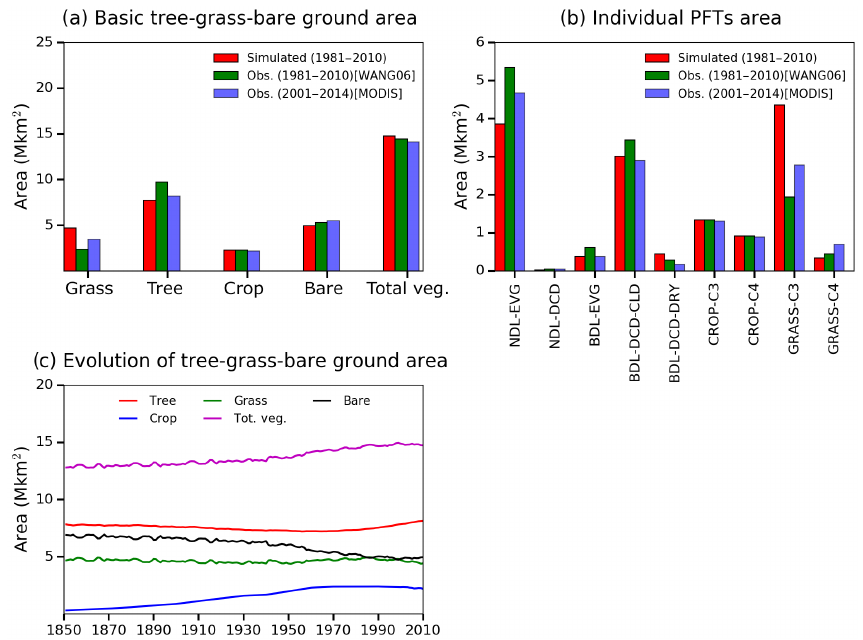
Figure 2. Comparison of observation-based and simulated vegetation areas summed over the North American domain: (a) grass, tree, crop, bare ground and total vegetated area; (b) individual PFT areas; and (c) evolution of simulated vegetation areas summed over the domain.